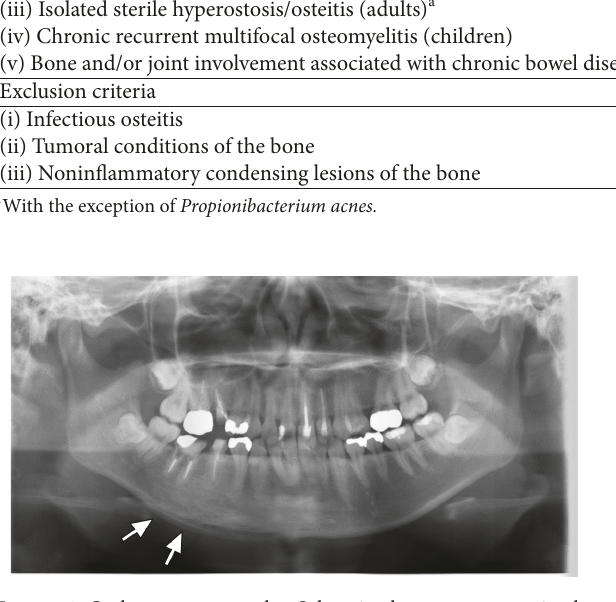
Figure 1: Orthopantomography. Sclerotic changes are seen in the right body of the mandible with periosteal reaction